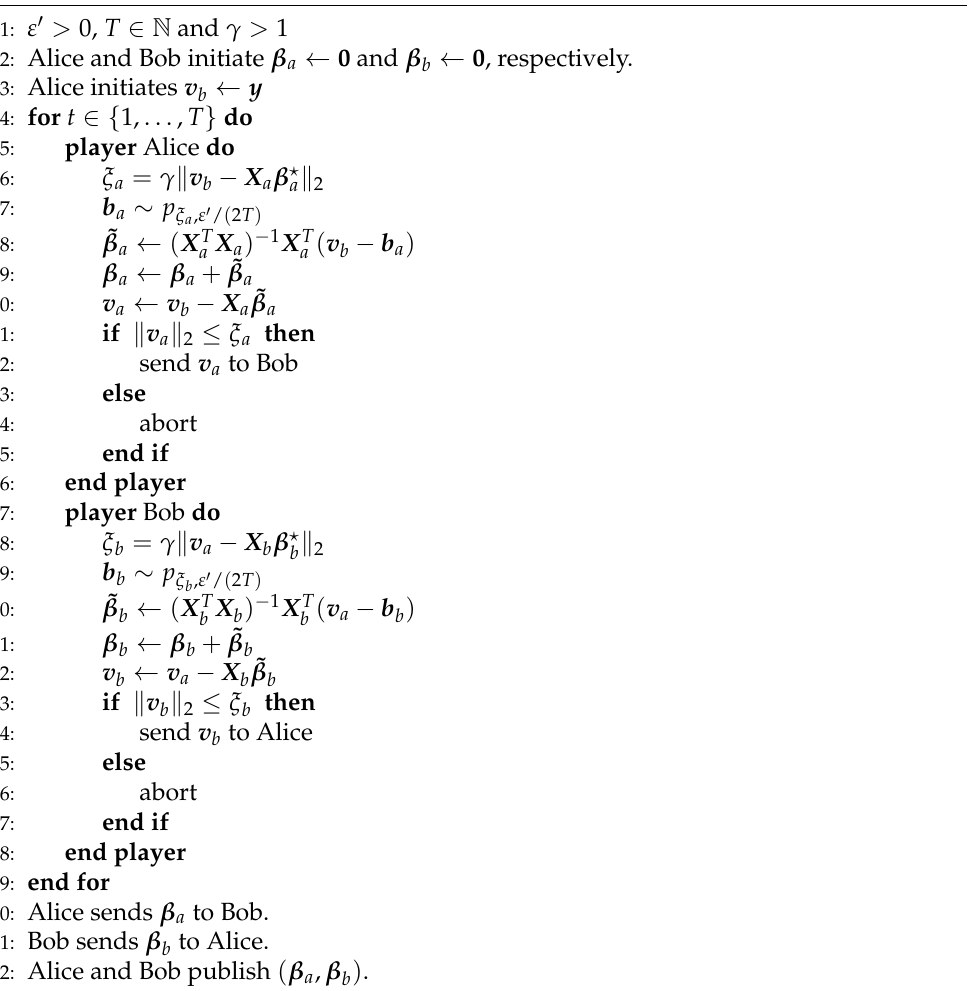
Algorithm 2 Differentially private 2-party block coordinate descent